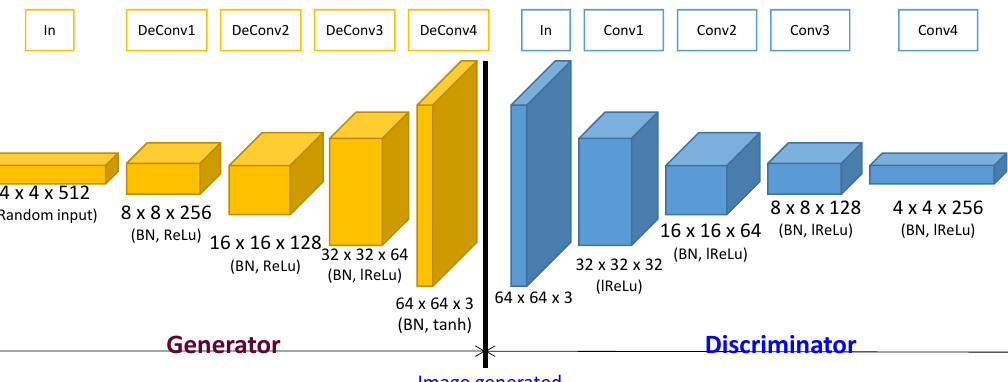
Figure 5. Deep convolutional generative adversarial networks (DCGAN) for generative model of BF-NSP images.